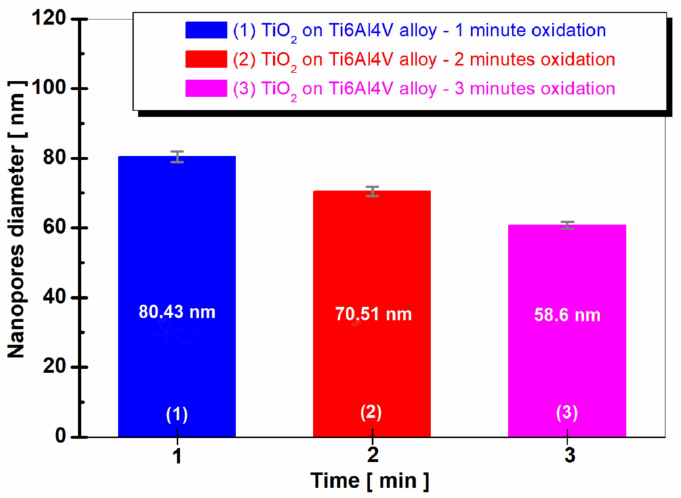
Figure 6. Average nanopore diameter size of the titanium oxide (TiO 2 ) film produced on the grade 5 Ti6Al4V alloy electrochemically oxidized in H 2 SO 4 solution: (1) at 200 V for 1 min, (2) at 200 V for 2 min, and (3) at 200 V for 3 min.